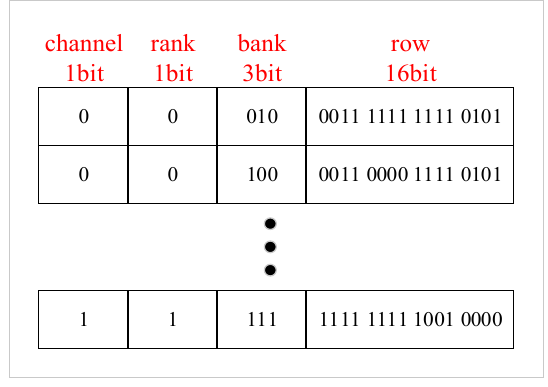
Figure 11. Organization of weak row register.